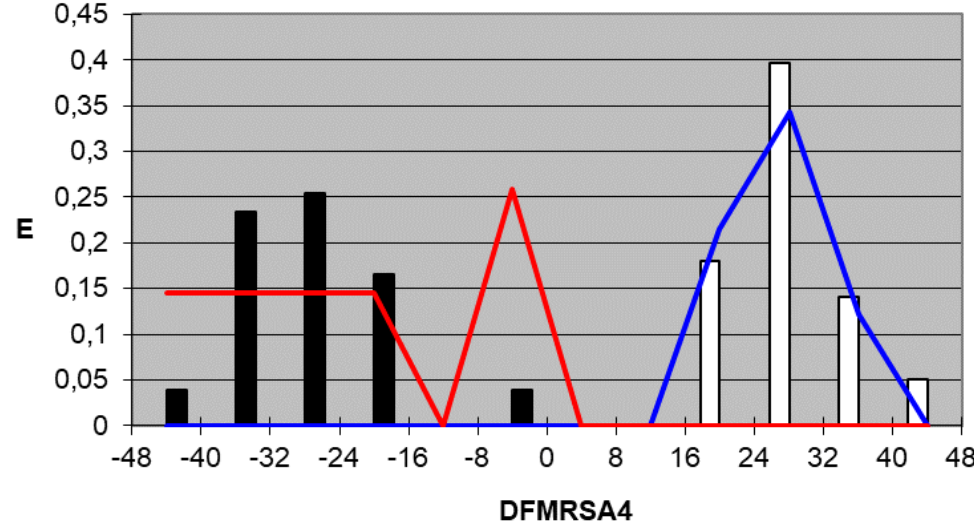
Figure 5. DF MRSA4 pharmacological distribution diagram. Black bars: Training Inactives. White bars: Training Actives. Red curves: Test Inactives. Blue curves: Test Actives.